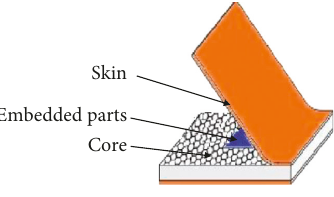
Figure 1: Embedded honeycomb structure.